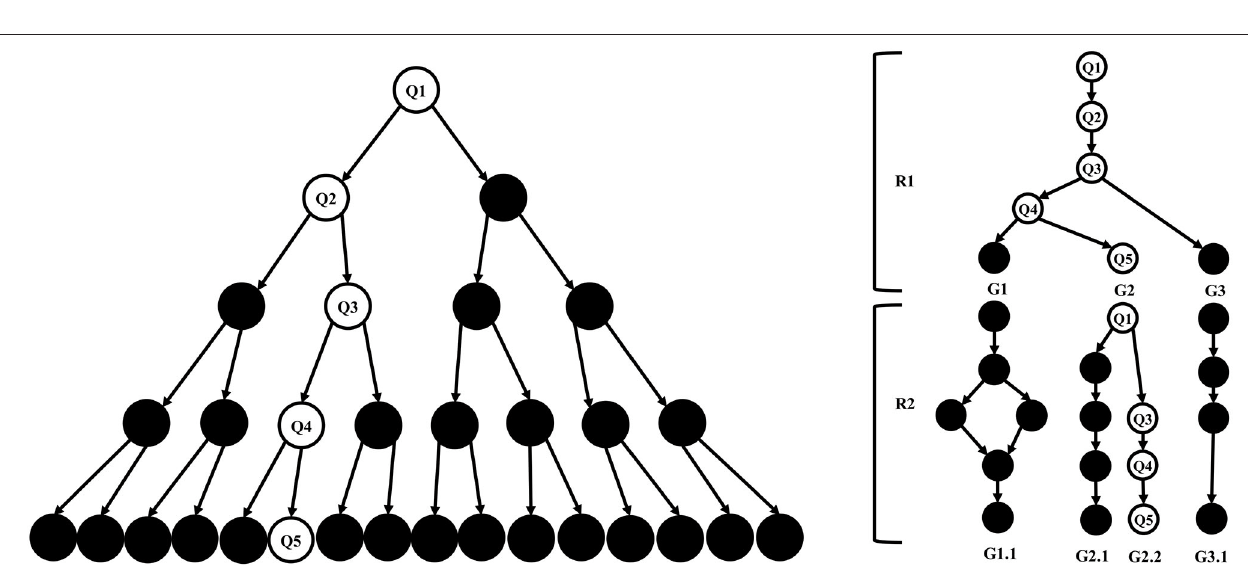
FIGURE 2 | Questions Q in a tree structure with branches and decision nodes (left) and survey rounds creating typology groups G for follow-up survey round R (right). Unfilled shapes show an example of a respondent’s pathway in the tree structure.